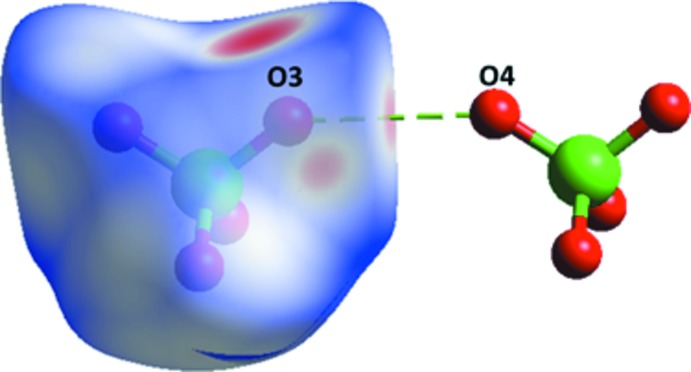
An inter­molecular O⋯O contact inter­connects adjacent percholorate anions.